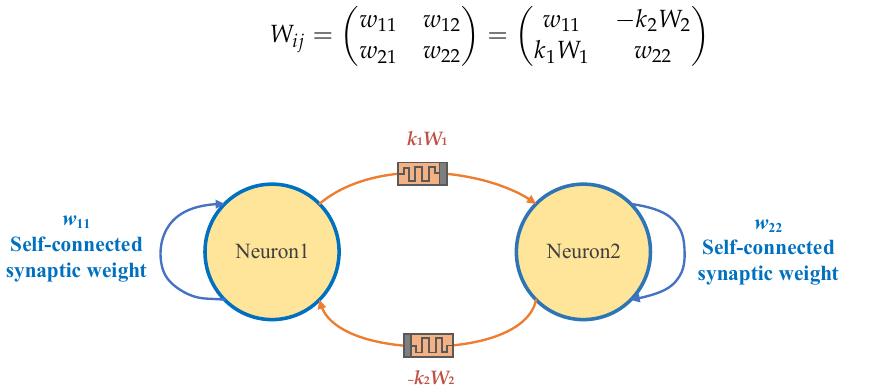
Figure 5. The simplest memristive HNN with synaptic crosstalk.